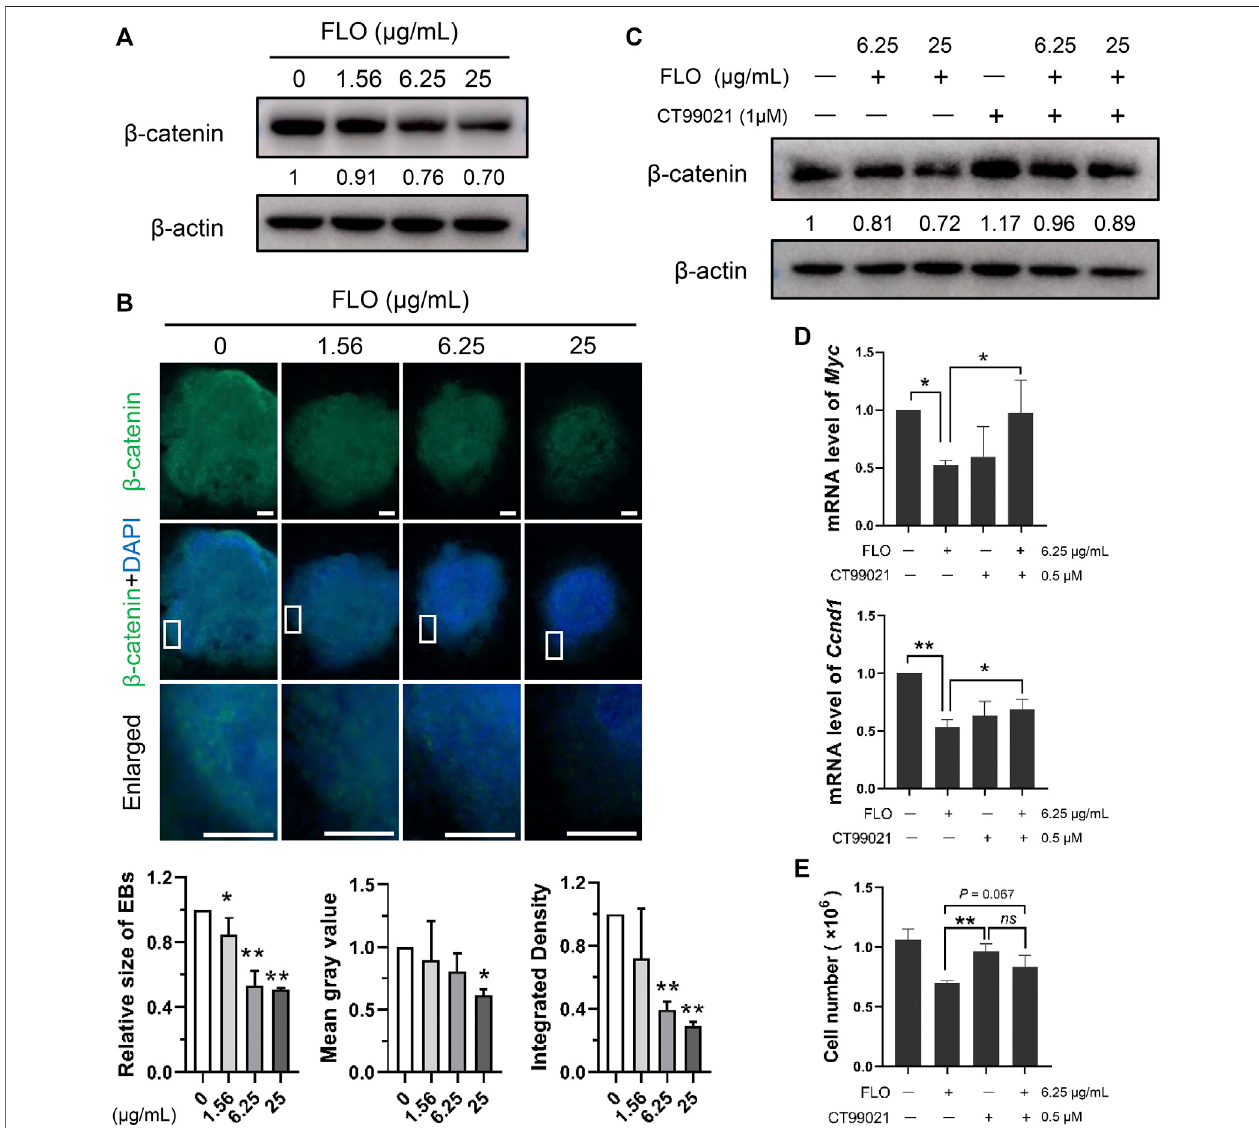
FIGURE 4 | The canonical Wnt pathway is engaged in mediating FLO-induced toxic effects. (A) Immunoblot analysis of FLO on protein levels of β -catenin in P19SCs treated for 48 h β -actin served as a loading control. Densitometry was performed for quanti fi cation and the ratios of β -catenin to β -actin are presented at the bottom oftheblots. (B) Immunostainingofthe differentiated EBs(day7) using FITC-conjugated β -catenin antibodies. Representative images areshown todemonstrate the in fl uences of FLO on the formation of EBs and the expression of β -catenin. DAPI was used to stain cell nucleus. Bar = 200 μ m. The relative size of EBs, mean gray value, and integrated density of β -catenin werequanti fi edusing Image Jsoftware. (C) ImmunoblotanalysisofCT99021 (activatorofthecanonicalWntpathway) on β -catenin levelinFLO-treated P19SCs. (D) EffectsofCT99021 onmRNAexpression levelsofMyc andCcnd1. (E) Thein fl uenceofCT99021 ontheproliferationofFLO- treatedP19SCs.5×10 4 cellswereculturedineachwellof12-wellplatesfor12 h.ThencellsweretreatedwithFLO(6.25 μ g/ml)andCT99021(0.5 μ M)foranother48 h. The results are expressed as the average cell numbers from three independent experiments. * p < 0.05, ** p < 0.01, as compared with the control group. ns , not signi fi cant.